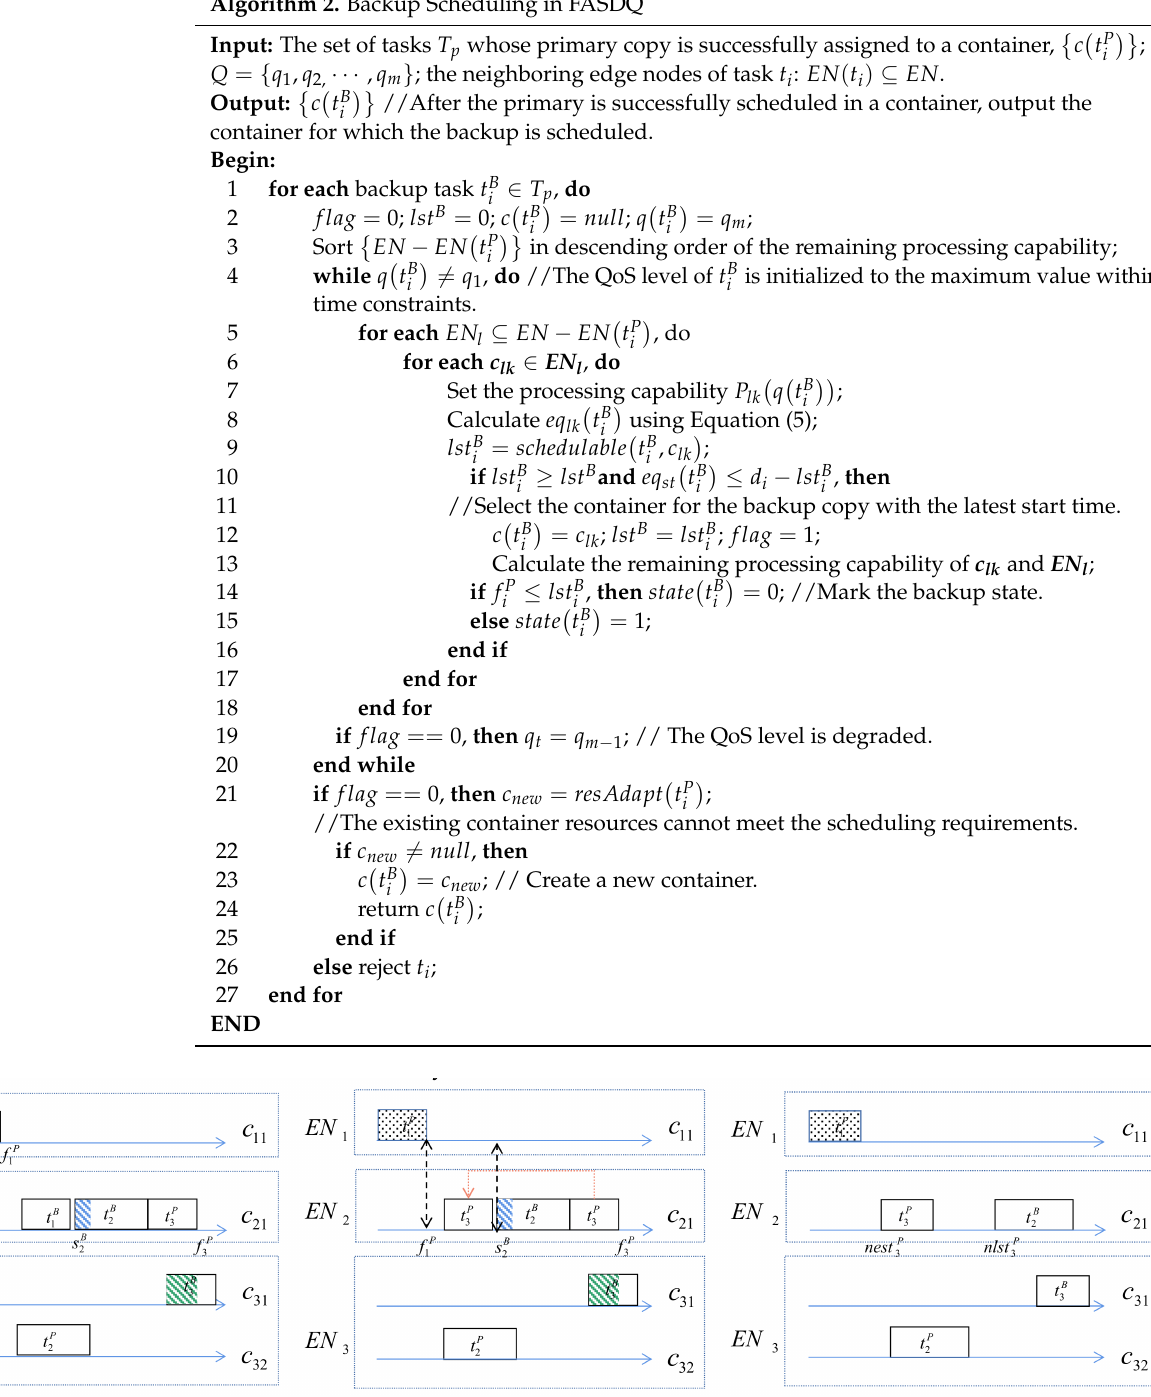
Figure 6. Task rescheduling process, is finished; ( b ) t B from active to